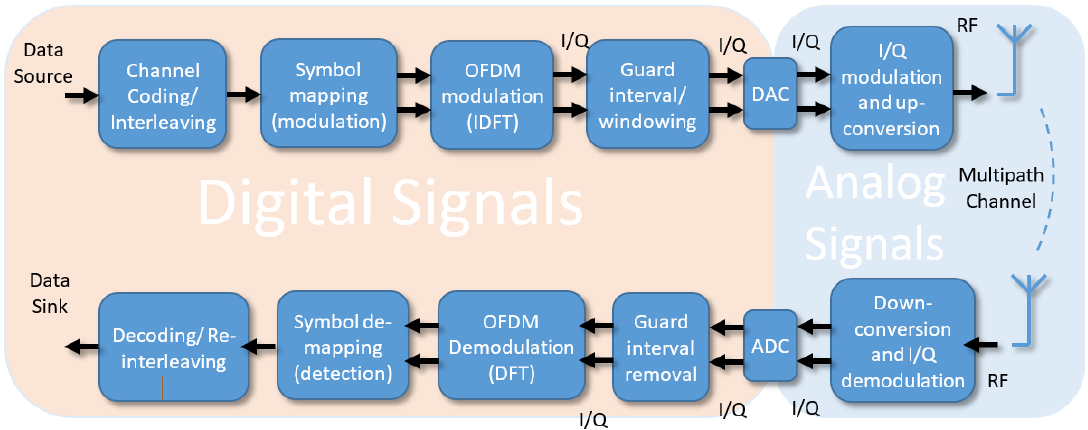
Figure 1. Block diagram of orthogonal frequency division multiplexing (OFDM) transmission [10].